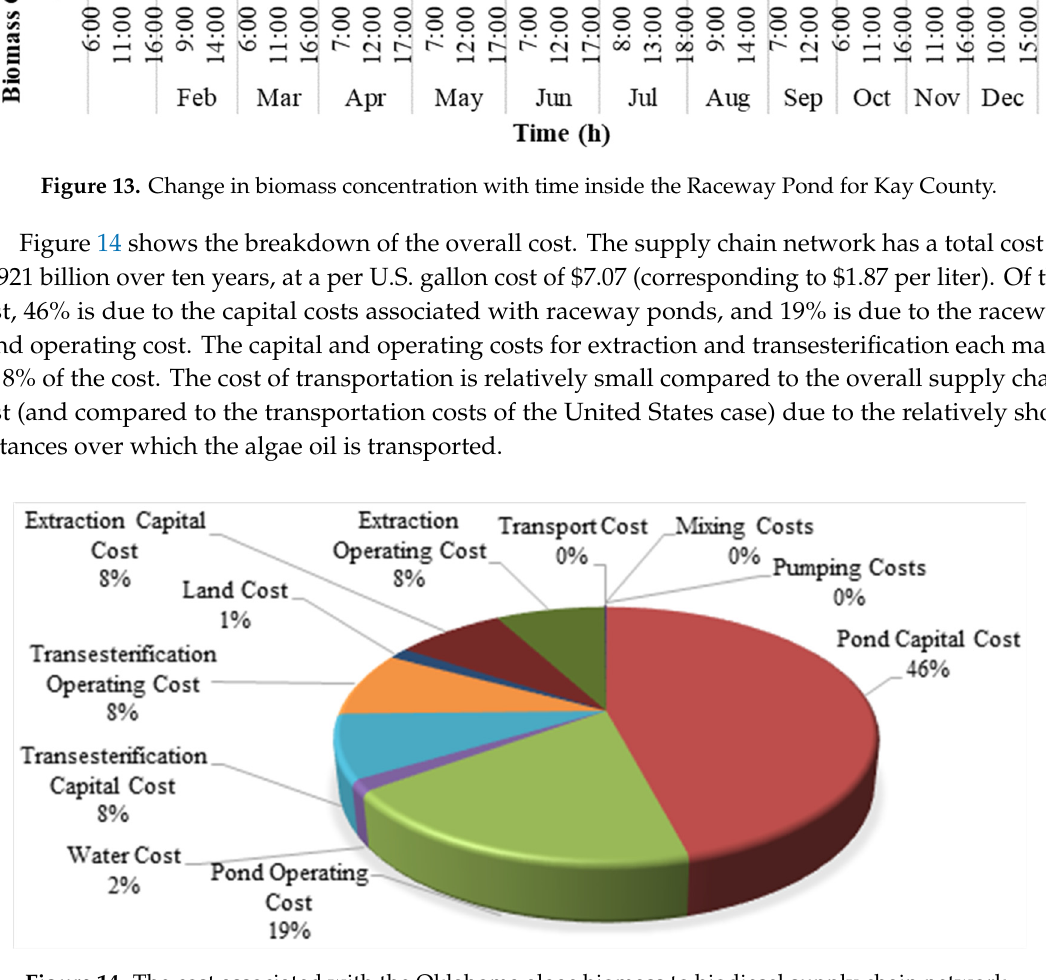
Table 9. Comparison of the solution from relaxed-MINLP and MILP solvers: CONOPT 3 version 3.17 A and CPLEX version 12.6.3.0 for the U.S. case. Relaxed-MINLP